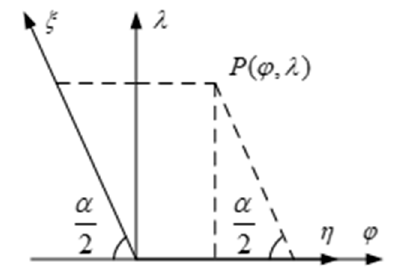
Figure 3. Diagram of coordinate transformation.